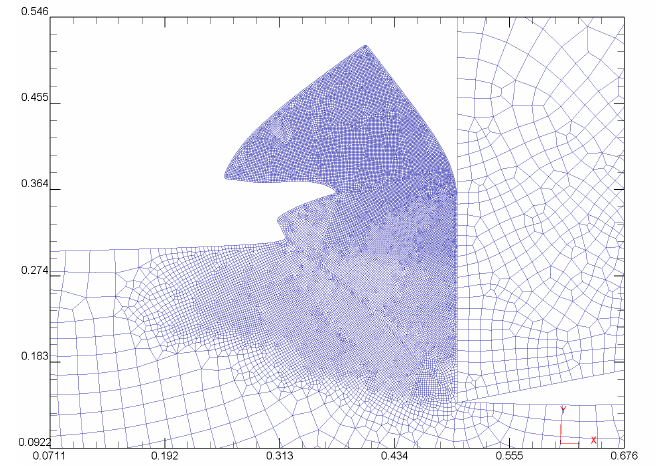
Figure 2. Mesh adaptivity during the simulation of adiabatic shear band (ASB) formation; minimum mesh size h min ≈ 0.4–1.6 µ m, maximum element size ratio =